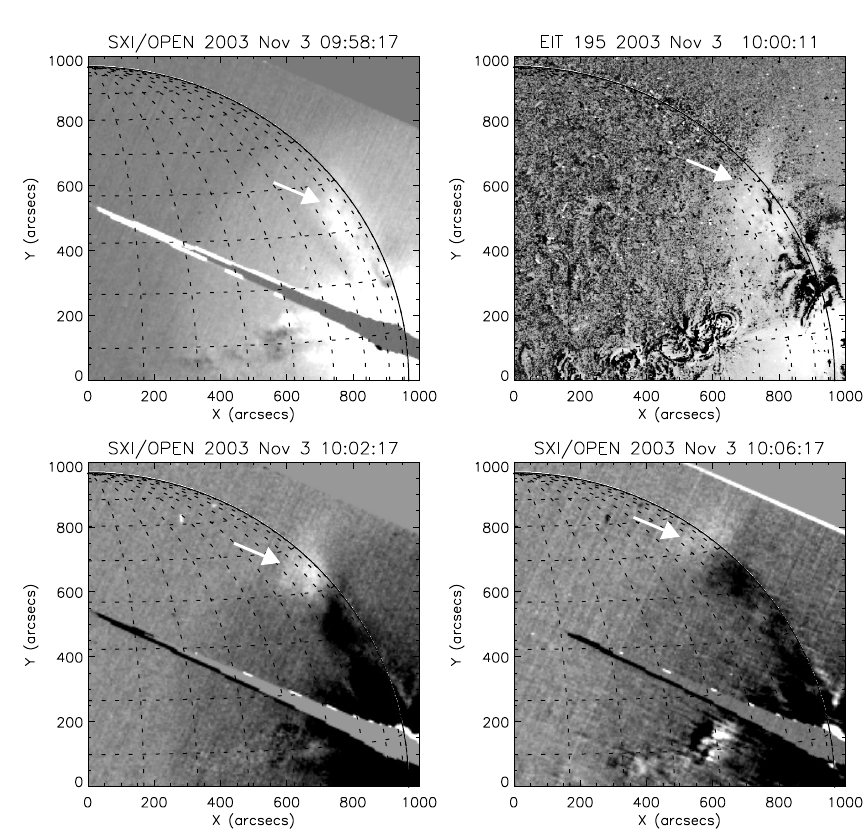
Figure 7: The coronal wave of 2003 Nov 3 observed in soft X-rays with GOES/SXI. Shown are running difference images. The wavefront is extended in height and can be observed above the solar limb. In the upper right panel, an EIT 195 ˚A difference image is shown for comparison. Note the morphological similarities with the X-ray signatures. Image reproduced with permission from Warmuth et al. (2005), copyright by